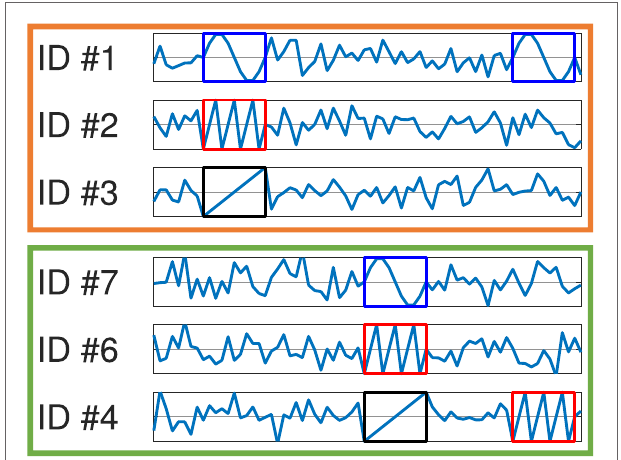
FIGURE 3 | An illustration of Assumption 1. There is a three-dimensional equivalence structure (ES) that has tuples ⟨ #1, #2, #3 ⟩ and ⟨ #7, #6, #4 ⟩ and a two-dimensional ES that has tuples ⟨ #1, #2 ⟩ , ⟨ #7, #6 ⟩ , and ⟨ #1, #4 ⟩ . In the two-dimensional sequences, there is a subsequence that is shown by blue and red